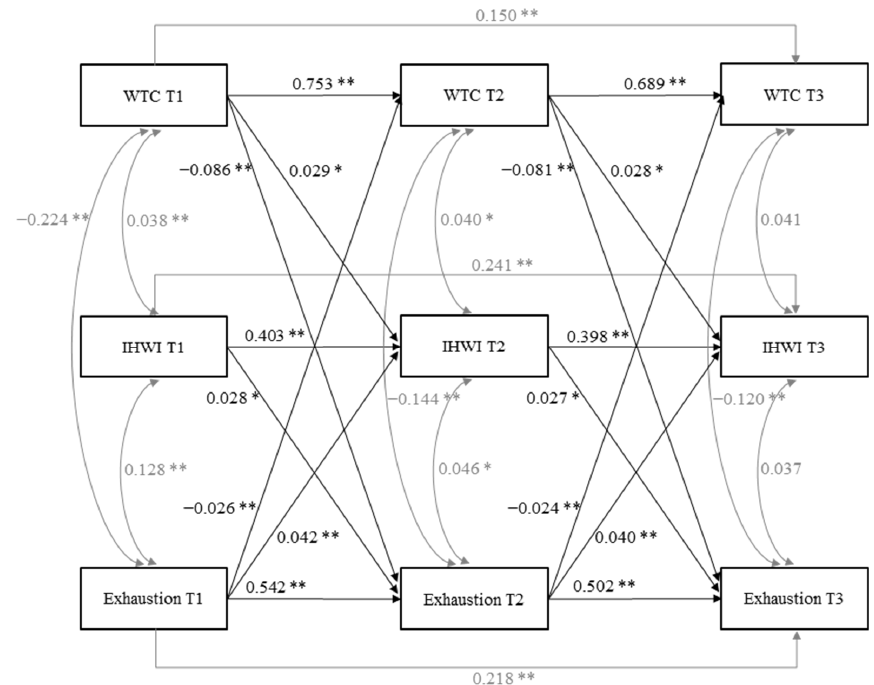
Figure A2. Final model (M5) with standardized coefficients for WTC, IHWI, and exhaustion (unbalanced panel). For clarity, control variables (gender, age, education level, living with a partner, underage child in household, weekly working hours, regular day work, and requirement level) are not shown. Control variables were regressed on the constructs at T1 only. * p < 0.01. ** p < 0.001. Table A1. Fit indexes and model comparisons for WTC, IWHI/IHWI, and exhaustion (unbalanced panel; n = 17,596–17,918).